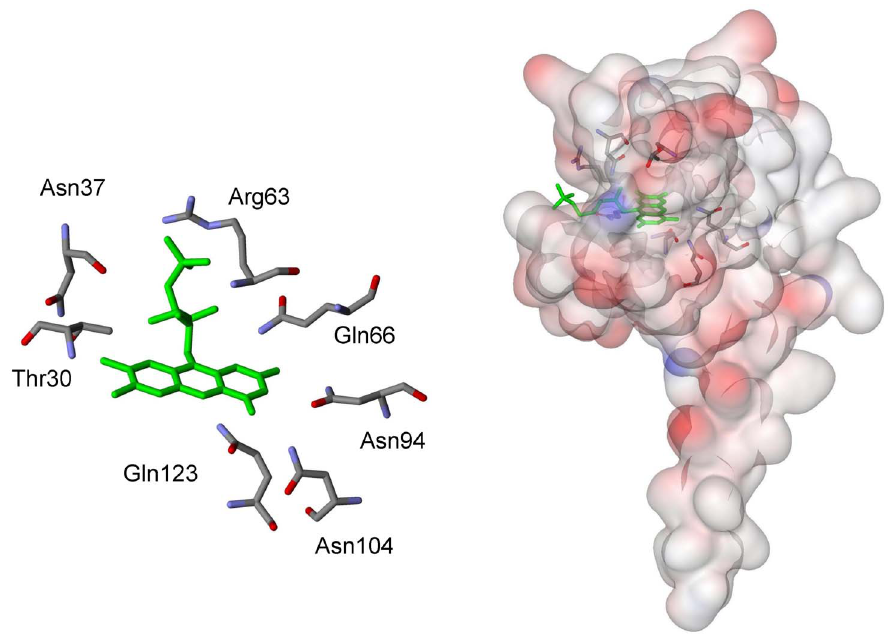
Figure 5. Three dimensional arrangement of mutated amino acids in YtvA. Left. Closeup of the YtvA chromophore (in green) with the amino acids considered in this study represented in capped sticks (red oxygen, blue nitrogen). Right. Solvent accessible surface visualization of the protein with the chromophore in green and the amino acids considered in this study represented in capped sticks.